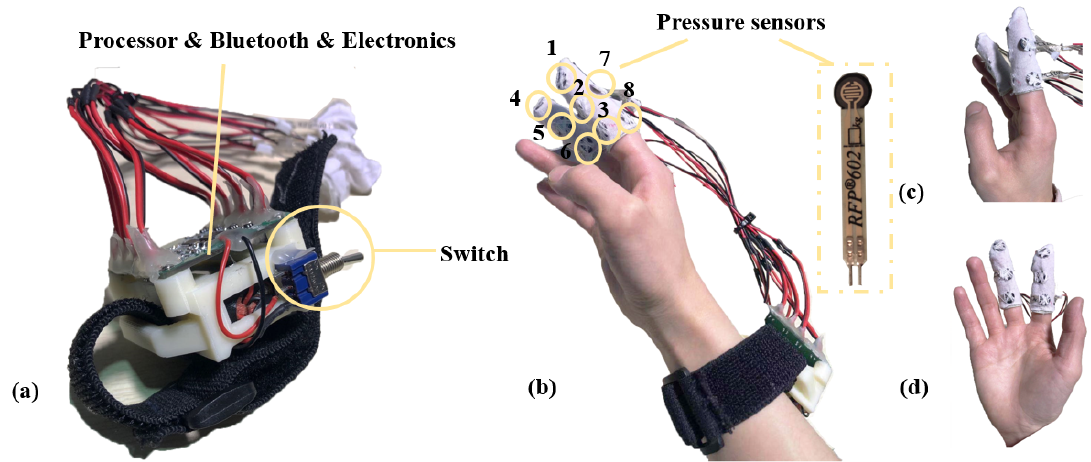
Figure 1. Structure of HiFinger-based interaction system. ( a ) HiFinger with 8 ultra-thin pressure sensors based on the index finger and middle finger; ( b ) one user is wearing the system; ( c ) the side view of the HiFinger-based system; ( d ) the front view of HiFinger-based